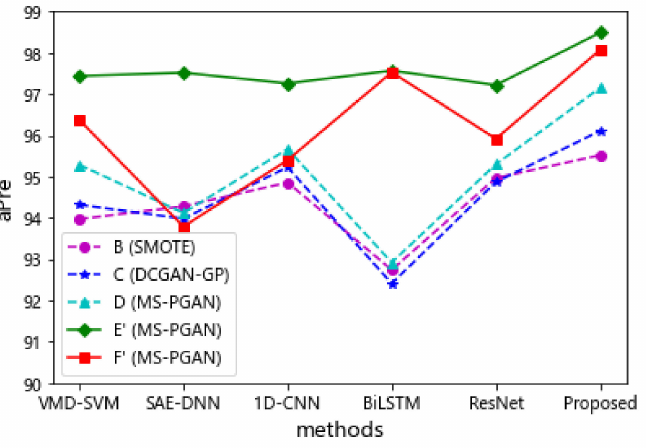
Figure 13. The average precision (%) of the baselines and our proposed method in all rebalanced datasets.